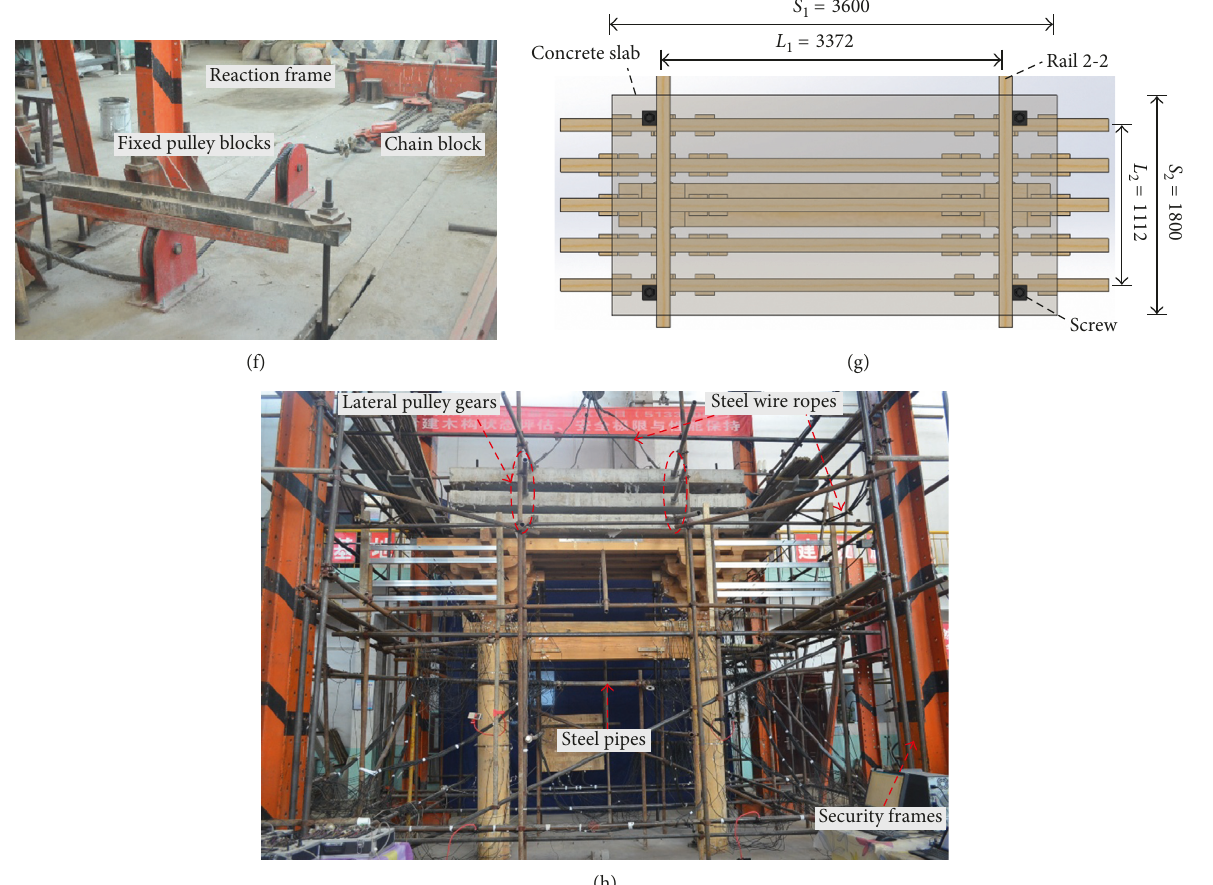
Figure 3: Loading equipment and safety devices (mm). (a) Overview of the test setup and layout of instrumentations; (b-c) spherical hinge bearings; (d-e) the connection of the bar chains; (f) mechanism of force application; (g) size of the concrete slab; (h) safety